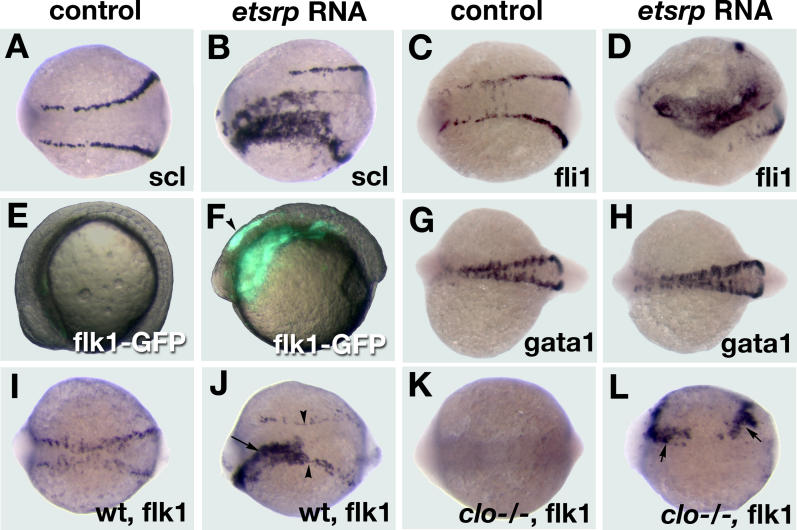
etsrp RNA Overexpression Induces Ectopic Expression of Vascular Endothelial MarkersDorsal view, anterior to the left in all panels except for (E,F) which are lateral views. (A, C, E, and G) Control uninjected embryo; (B, D, F, and H) 100 pg of etsrp RNA-injected embryo. (A,B) scl expression at the eight-somite stage; (C,D) flk1 expression at the nine-somite stage. Note the strong ectopic induction of scl and fli1 upon overexpression of etsrp RNA. (E,F) Live flk1-GFP embryo at the 14-somite stage; fluorescent and transmitted light images were overlayed. Note the very strong ectopic induction of GFP expression in different tissues including neuroectoderm (arrow, F) upon etsrp RNA overexpression. Fluorescence in the control uninjected flk1-GFP embryo in (E) is not detectable under the same exposure. (G,H) gata1 expression at the 16-somite stage. Note that gata1 expression is not affected upon etsrp overexpression. (I–L) etsrp RNA induces flk1 expression in clo mutant embryos as analyzed using flk1 probe at the ten- to 12-somite stages. (I) wt (or clo+/−) embryo, (J) wt (or clo+/−) embryo injected with 100 pg of etsrp RNA, (K) clo−/− embryo, (L) clo−/−embryo injected with 100 pg of etsrp RNA. Note that in a clo+/− (or wt) embryo etsrp RNA induces ectopic flk1 (arrow, J) in addition to the endogenous flk1 expression (arrowheads, J) while clo-/− etsrp RNA-injected embryo shows only ectopic flk1 (arrows, L).